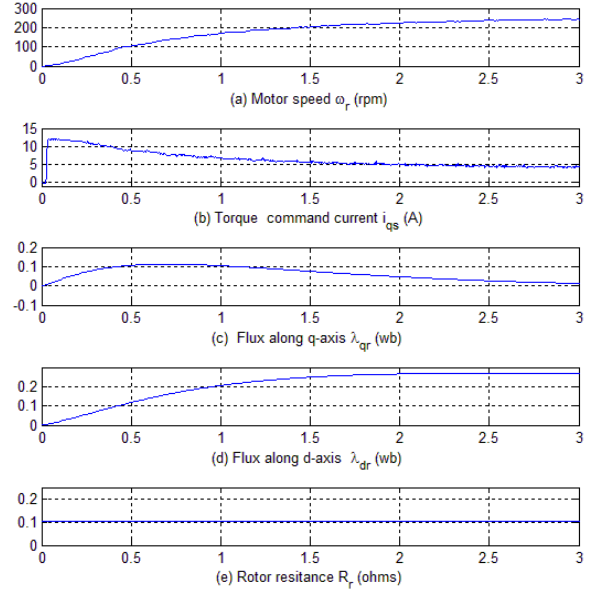
Figure 15. Experimental results with R r /4 and no adaptation. ( a ) Motor speed in rpm; ( b ) Torque command current in synchronous frame of reference; ( c ) Flux along q-axis in synchronous frame of reference; ( d ) Flux along d-axis in synchronous frame of reference; ( e ) Rotor resistance.